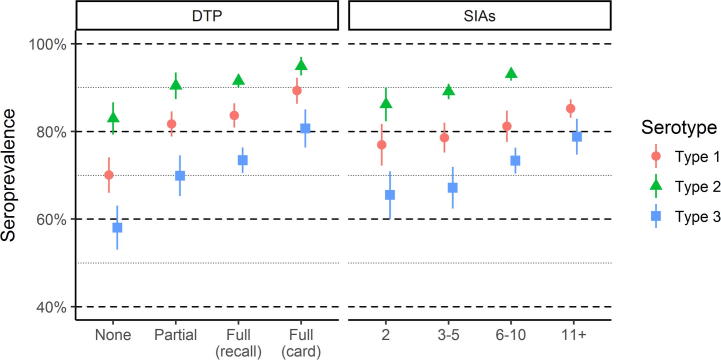
Seroprevalence by routine immunization status and SIA eligibility. Note, fewer SIAs with type-2 containing vaccine were conducted than for types 1 and 3. Thus, estimates for type 2 seroprevalence are not available for children who have experienced 11 or more SIAs.